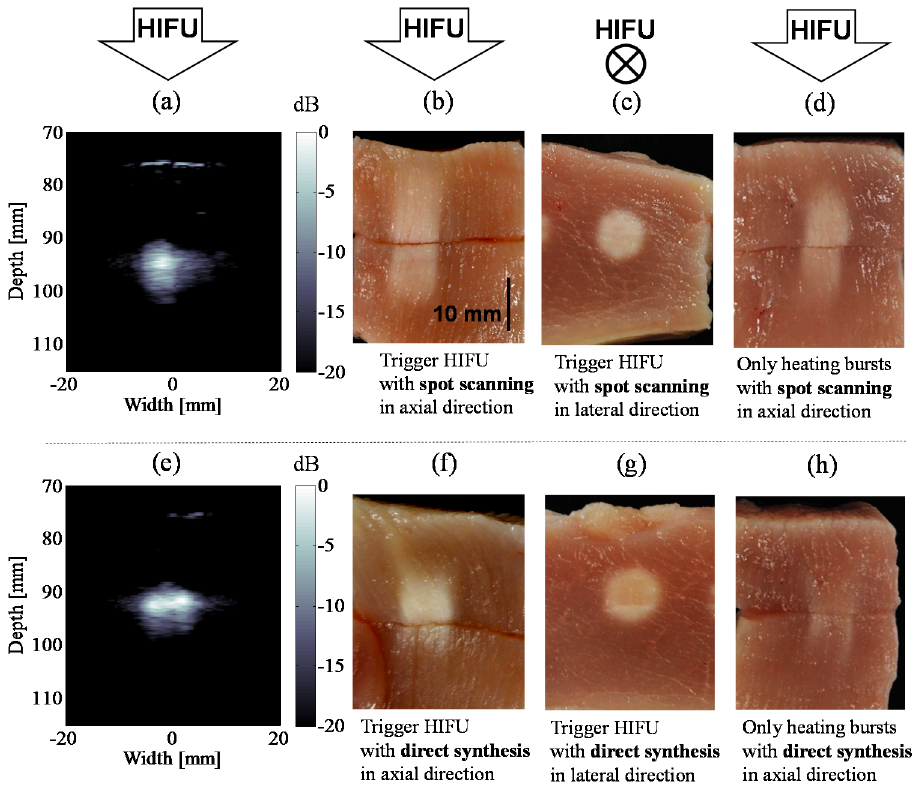
Figure 13. Typical ultrasound images of cavitation bubbles during HIFU exposure and slices of chicken tissue samples after HIFU exposure [35]. Heating bursts with spot scanning and direct synthesis were exposed for ( a – h ), respectively. Trigger HIFU sequences shown in Figure 1b,c were used for ( a – c , e – g ), respectively; ( a , d ) variance images of high-speed pulse inversion data by transmitting diverging waves; ( b , f ) the gross pathology in the longitudinal cross section; ( c , g ) the gross pathology in the lateral cross section; and ( d , h ) the gross pathology in the longitudinal cross section without trigger pulses.